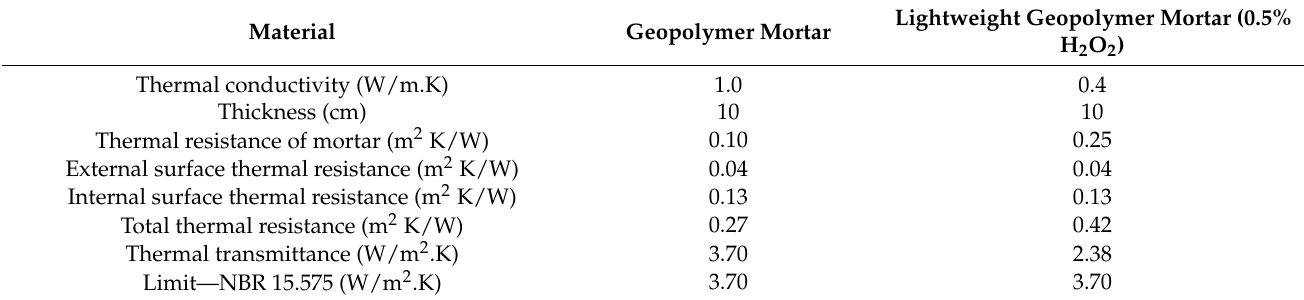
Table 3. Thermal conductivity and thermal transmittance used for the mortars. Material Geopolymer Mortar